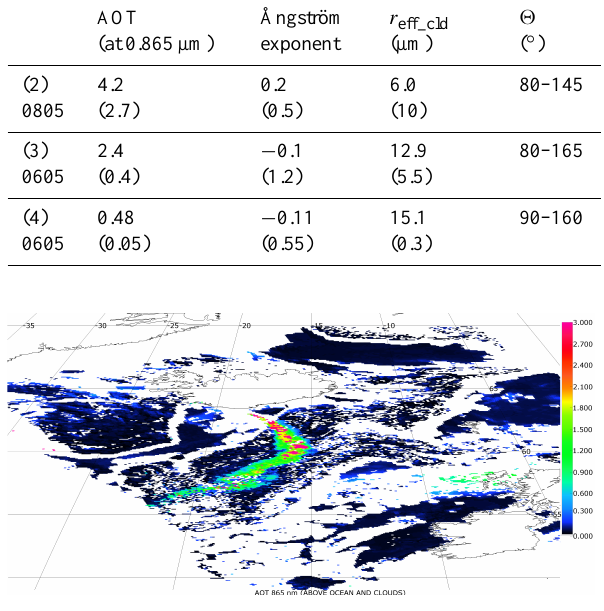
Fig. 7. Aerosol optical thickness retrieved at 0.865µm by POLDER over both ocean cloud-free pixels and cloudy pixels. The AOT val- ues are relative to the PARASOL overpass on 8 May